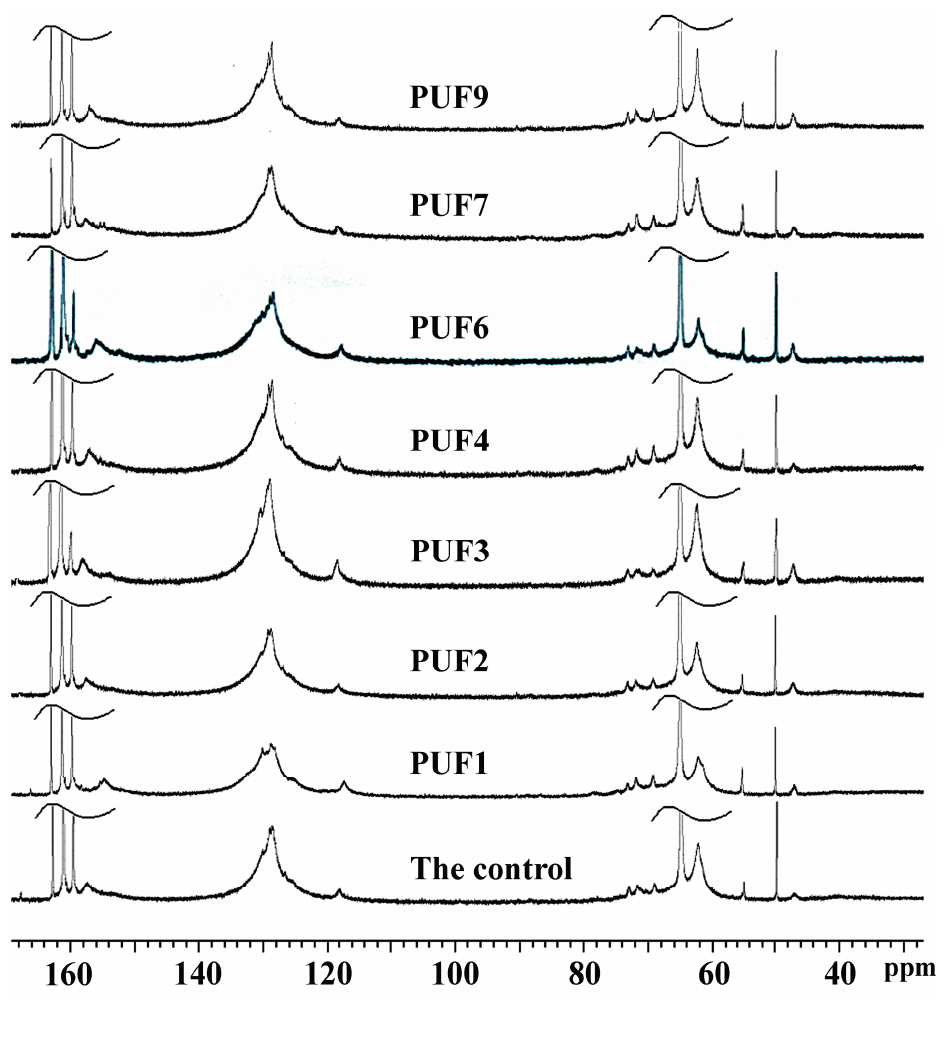
Figure 2. Liquid 13 C-NMR spectrum of PUF resins with different synthesis